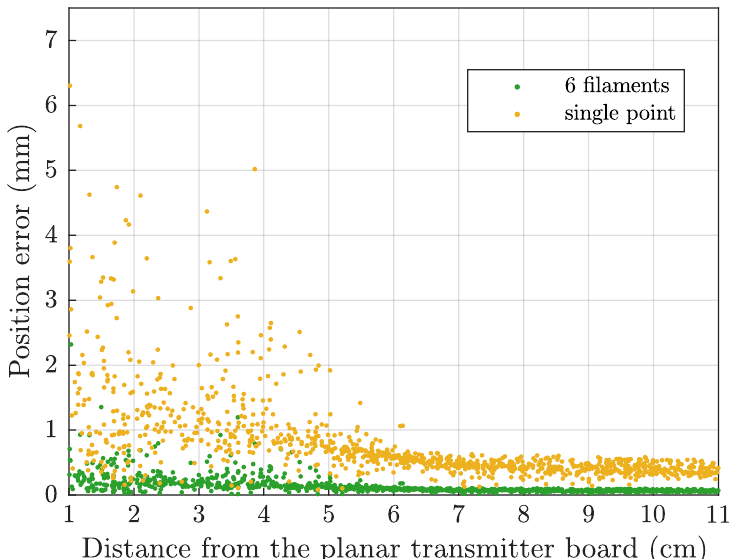
Figure 13. Static accuracy test simulation with no added noise. Position errors are due to model approximations. The two simplified models presented in Section 5.1 are compared.